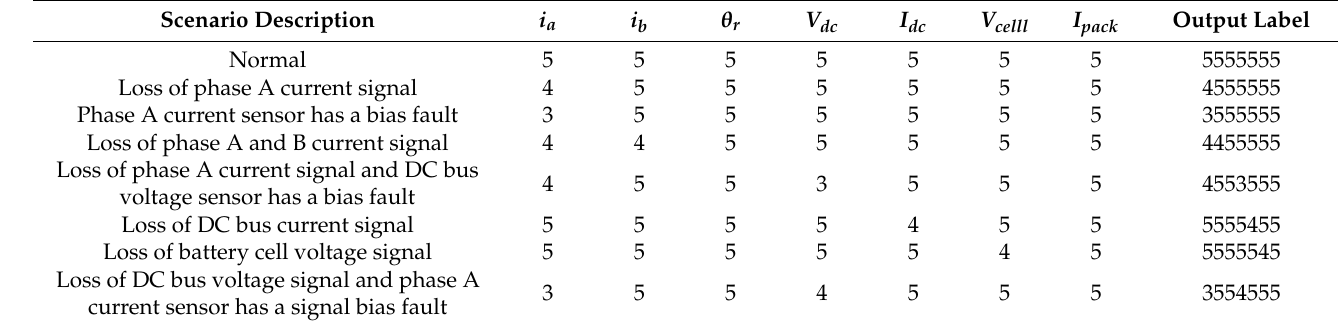
Table 3. Sensor fault scenario and output label